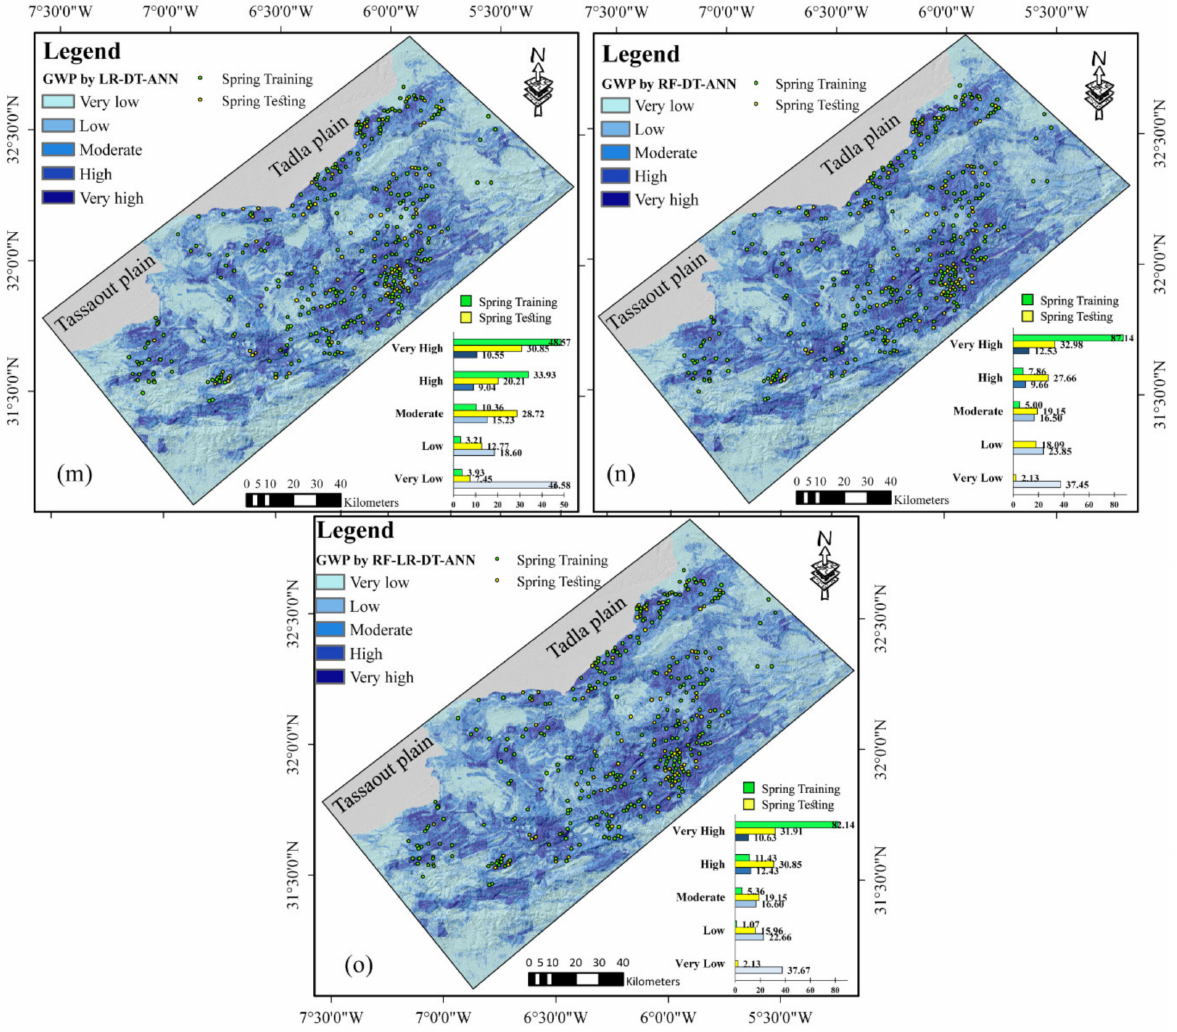
Figure 8. GSPM obtained from RF ( a ), LR ( b ), DT ( c ), ANN ( d ), RF-LR ( e ), RF-DT ( f ), RF-ANN ( g ), LR-DT ( h ), LR-ANN ( i ), DT-ANN ( j ), RF-LR-DT ( k ), RF-LR-ANN ( l ), RF-DT-ANN ( m ), LR-DT-ANN ( n ) and RF-LR-DT-ANN ( o )